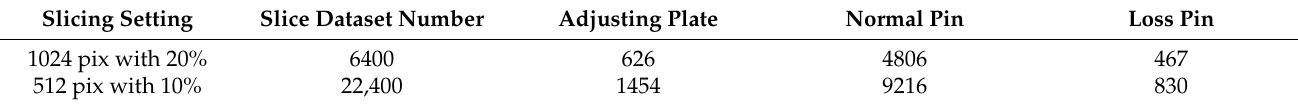
Table 2. The number of objects.